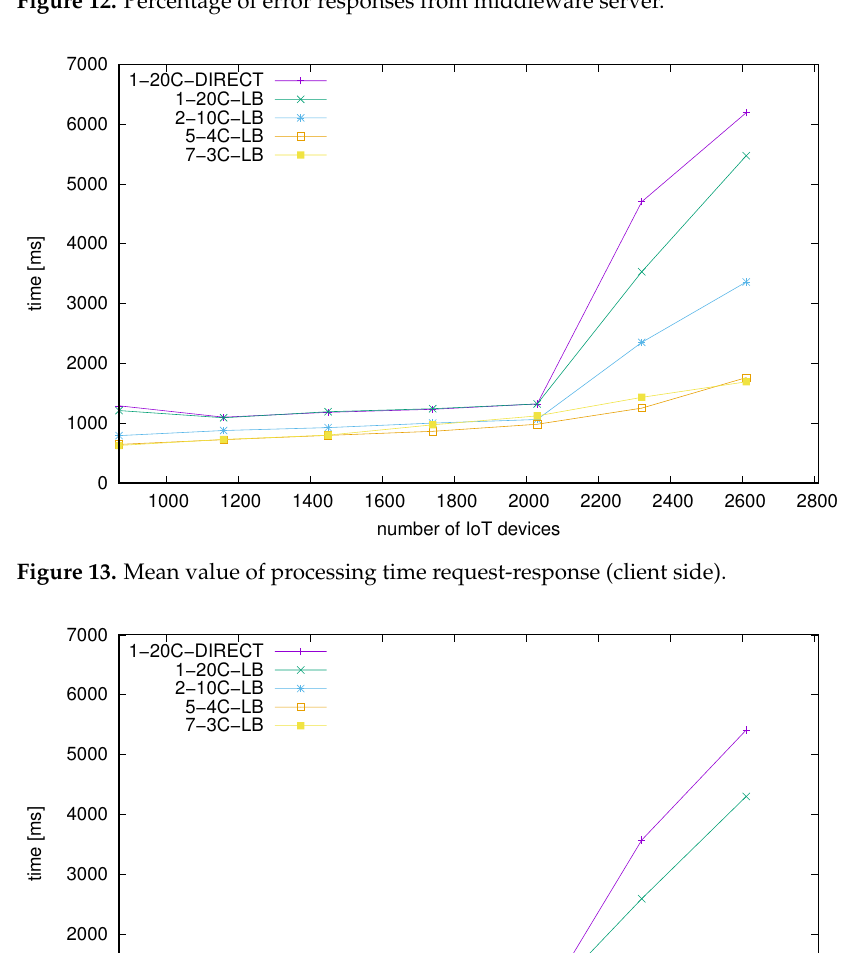
Figure 12. Percentage of error responses from middleware server.